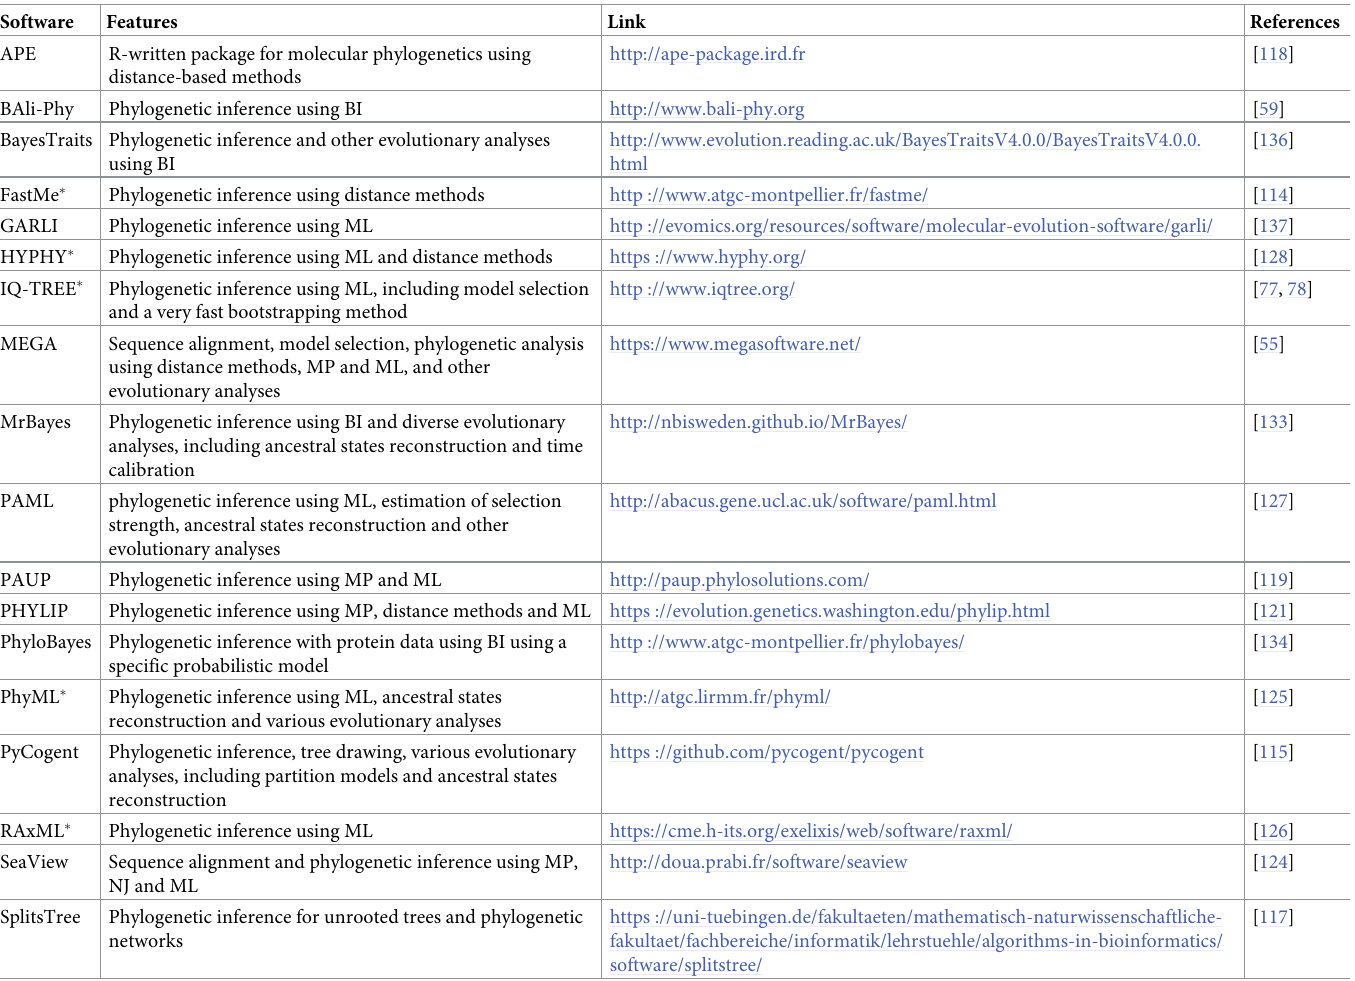
Table 7. List of programs for phylogenetic analysis using distance methods, maximum parsimony, maximum likelihood and Bayesian inference.